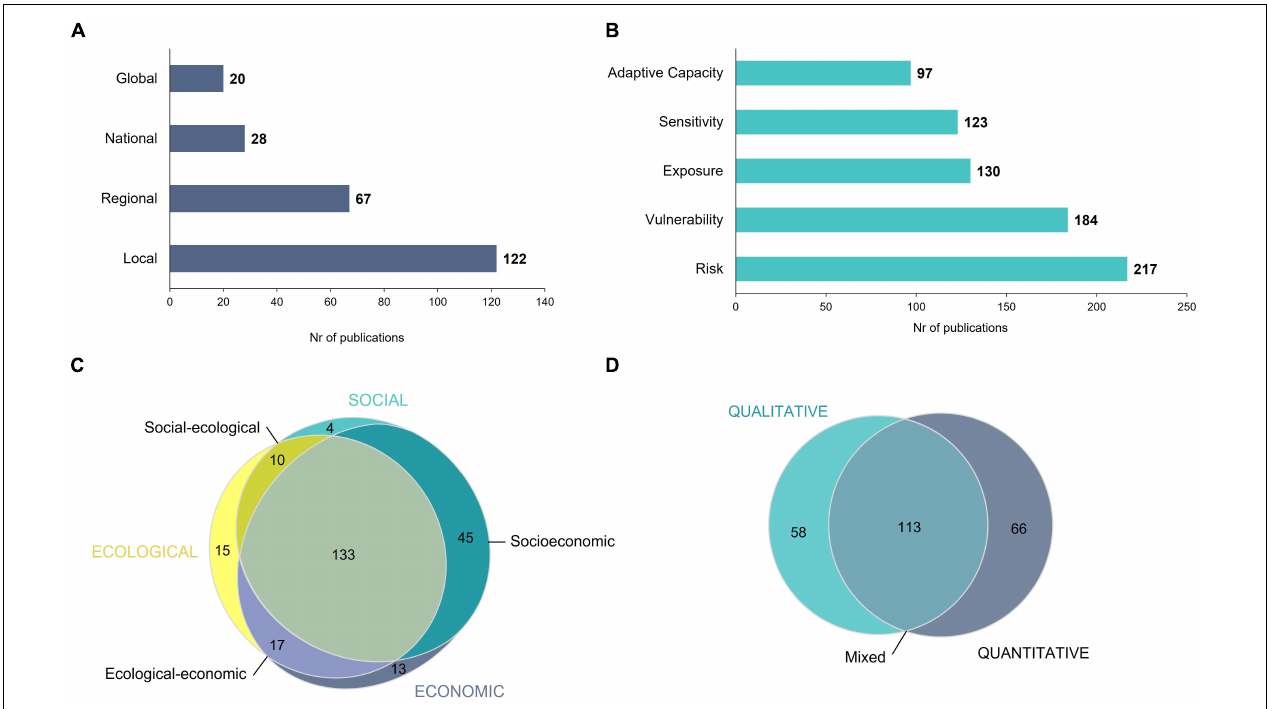
FIGURE 2 | Number of case study-based publications according to the spatial scale of the publication (A) , risk and vulnerability-related elements considered in the analysis (B) , dimensions focused by the analysis (C) , and type of indicator used (D) . Proportional Venn diagrams (C,D) were developed using R Statistical Software. See Supplementary Tables 3 , 4 for